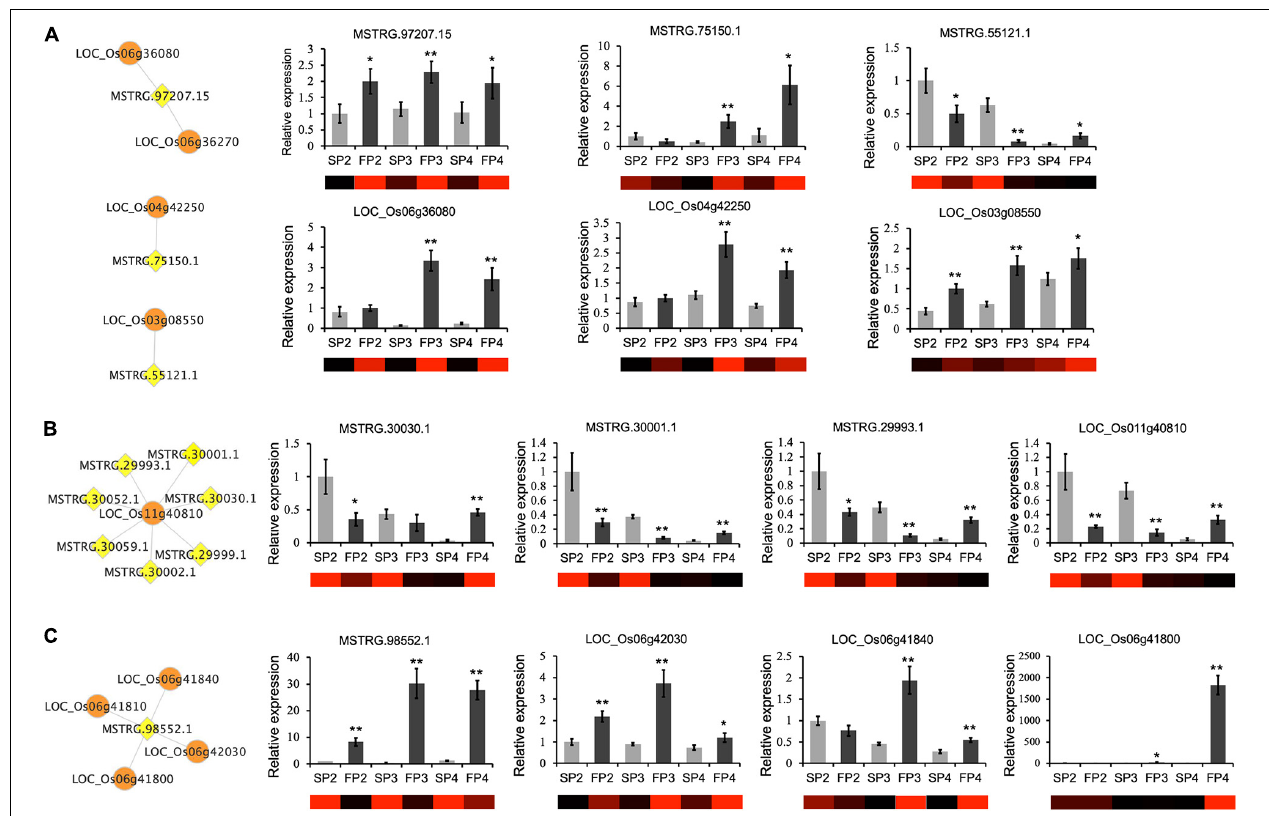
FIGURE 6 | qRT-PCR confirmation of relative expression levels of lncRNAs and their target genes that play potential roles in the pollen and anther development. (A) The expression patterns of lncRNAs are similar or opposite to those of their corresponding target genes. (B) Multiple lncRNAs were predicted to regulate one target gene. The expression pattern of three lncRNAs and one target gene was verified by qRT-PCR. (C) One lncRNA was predicted to regulate several target genes. The expression pattern of one lncRNA and three corresponding target genes was verified by qRT-PCR. The networks show the predicted interaction between lncRNAs (yellow diamond nodes) and target mRNAs (orange round nodes). The heatmaps are generated from the FPKM values in the RNA-seq data. The means ± SDs of three biological replicates ( n = 3) are shown. The asterisks indicate significant differences in WXS-F compared with WXS-S as determined by Student’s t -test (* P < 0.05; ** P <